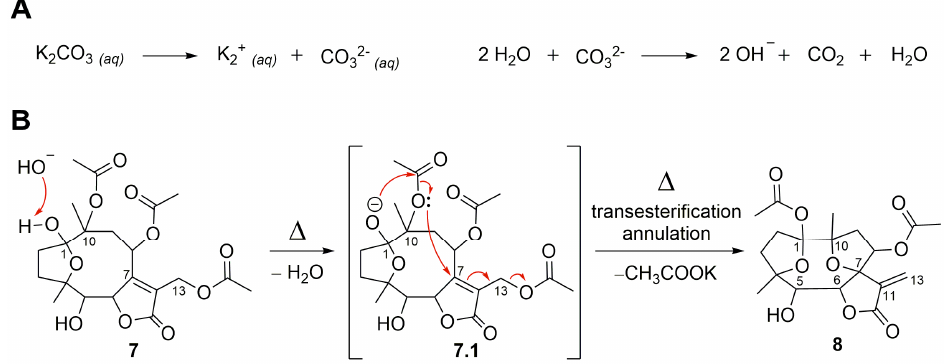
Figure 8. Proposed mechanism for the formation of SL semisynthetic derivative 8 involving an alkaline pH promoted by aqueous K 2 CO 3 dissociation ( A ) and a rearrangement via transesterification and annulation ( B ) (red arrows illustrate the arrow-pushing mechanism).